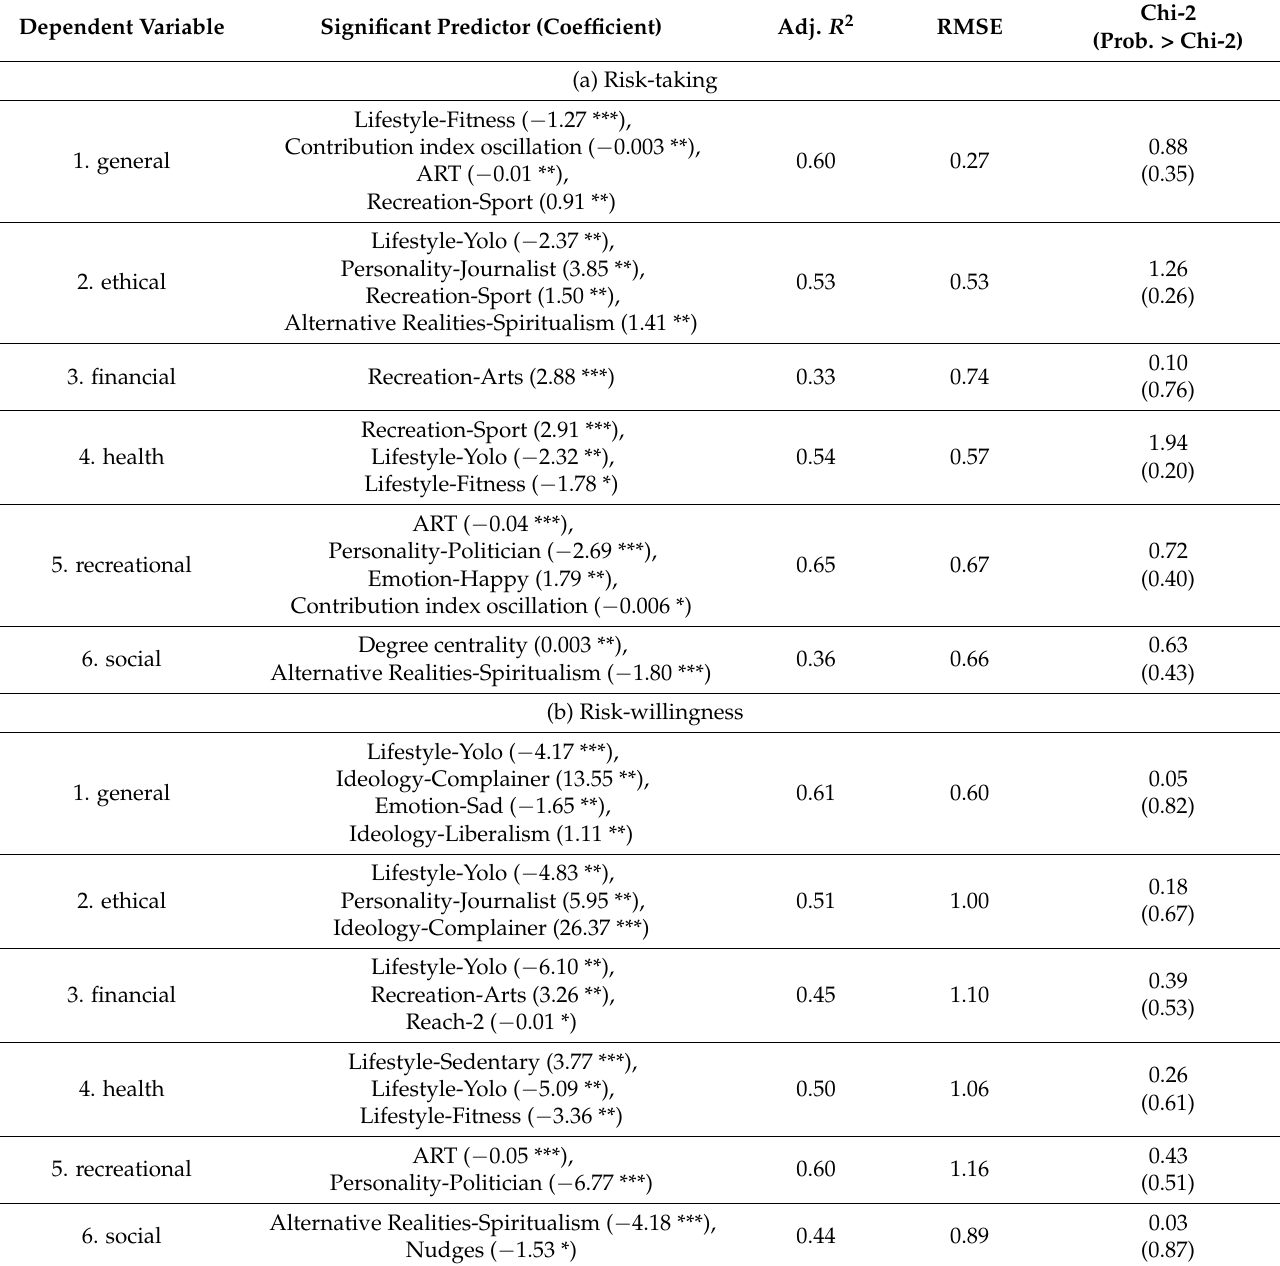
Table 3. Ordinary least squares (OLS) regression on the risk-taking and risk-willingness of Study A ( N = 34). The stars within the bracket correspond to the predictor’s significance level: * p < 0.1, ** p < 0.05, *** p <